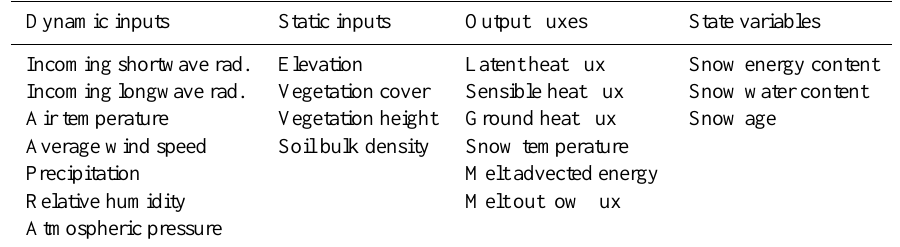
Table 1. Snowmelt model inputs, outputs, and state variables. The input includes static distributed parameters and dynamic meteorological